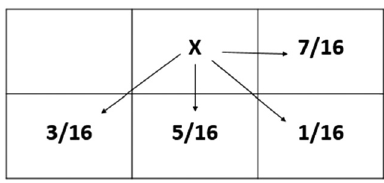
Figure 3: Floyd – Steinberg error di ff usion